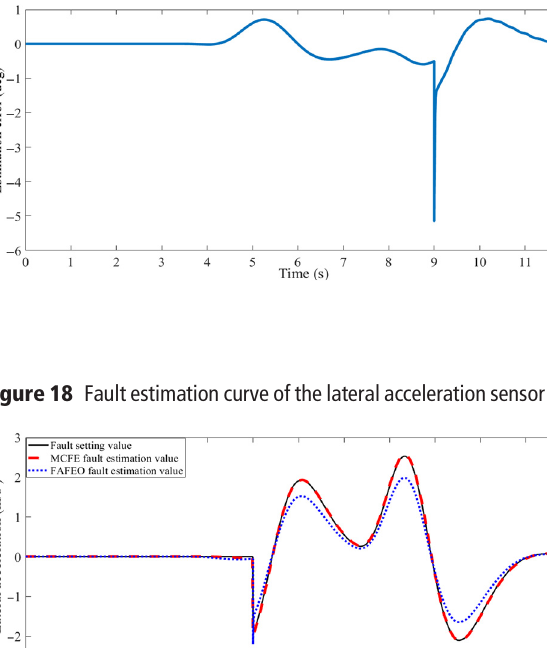
Figure 21 Fault estimation error curve of the rotation angle sensor